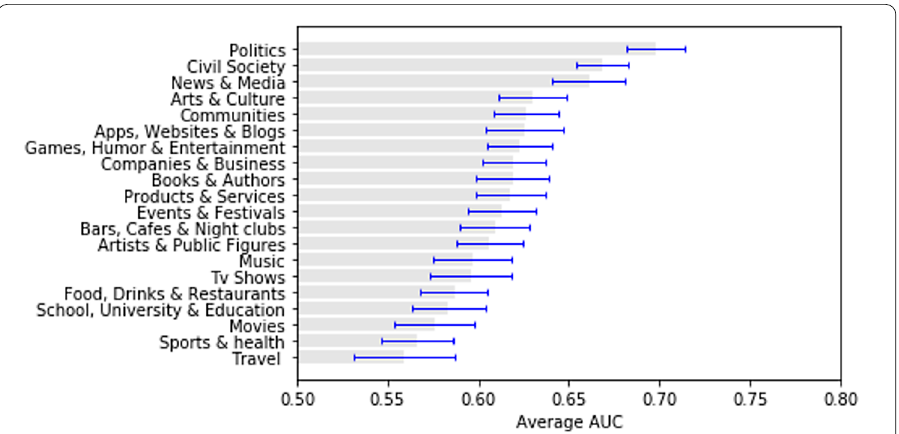
Figure 2 Average AUC (+/- 1 std) for the Facebook categories with target